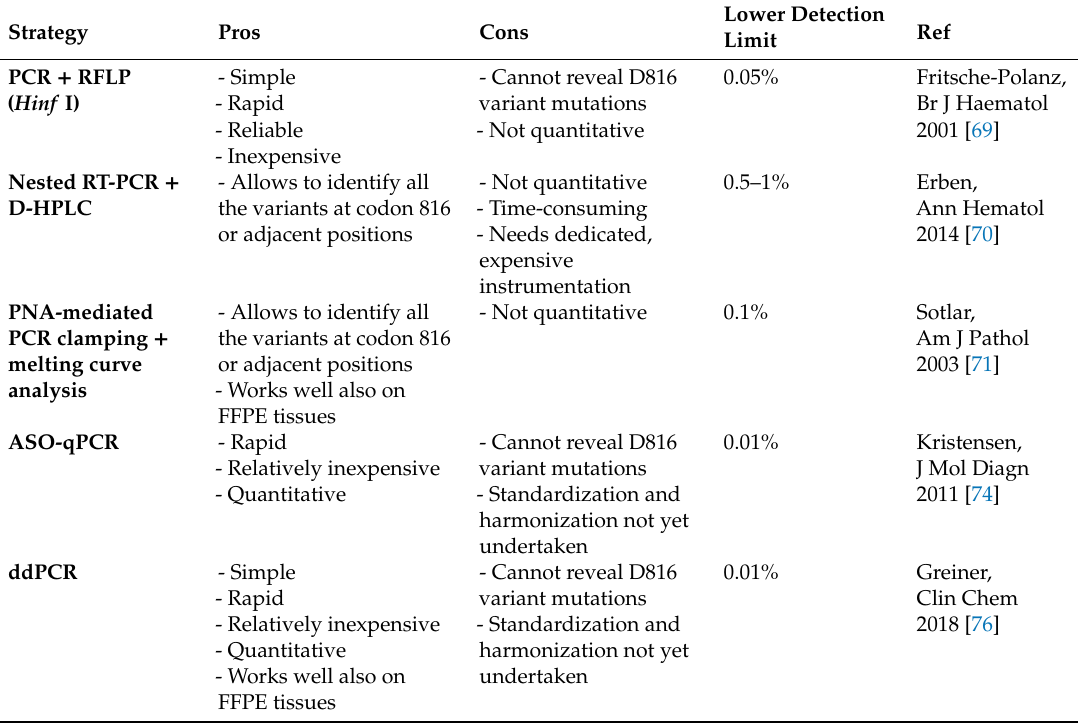
Table 1. Advantages, disadvantages, and sensitivity of the di ff erent methods most commonly used for KIT gene mutation